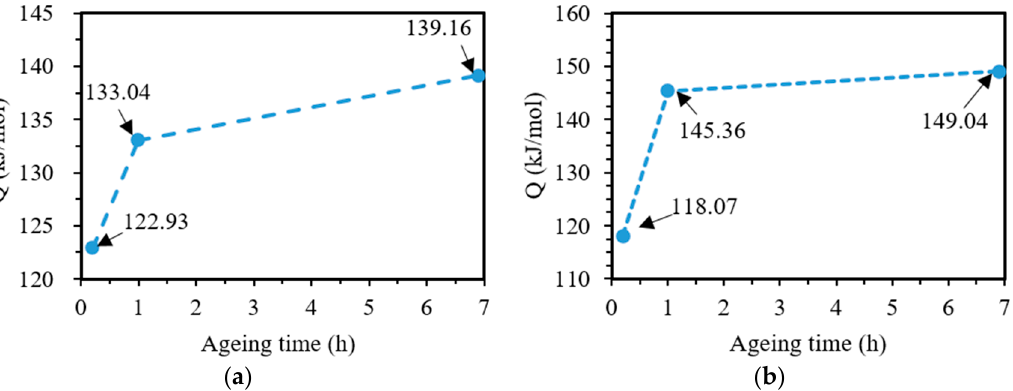
Figure 7. The activation energy Q evolution between ( a ) creep and ( b ) stress relaxation